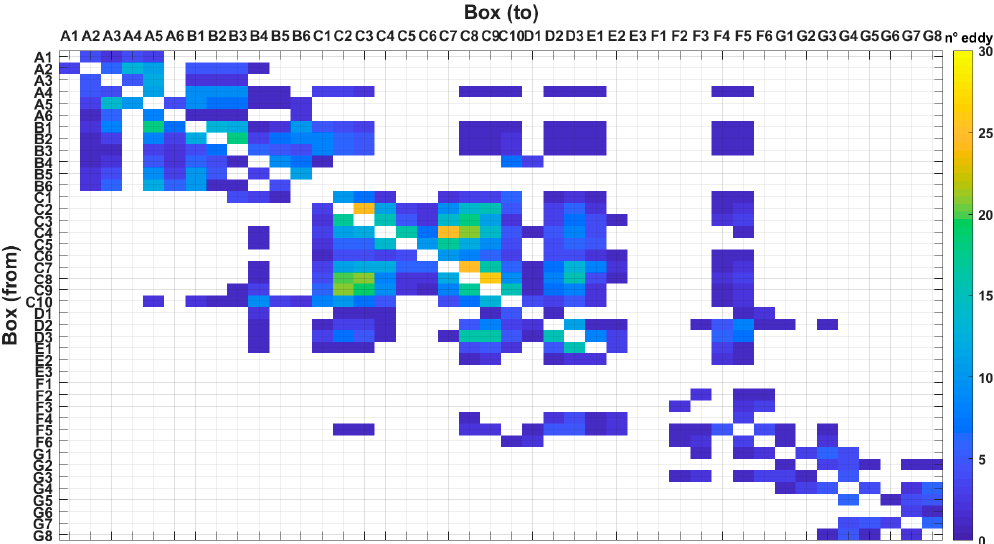
Figure 8. Number of anticyclonic eddies connecting the 42 boxes of the WMED. Each box extends over a 1° × 1° cell. Anticyclonic eddy tracks data refer to the 1993–2016 period.